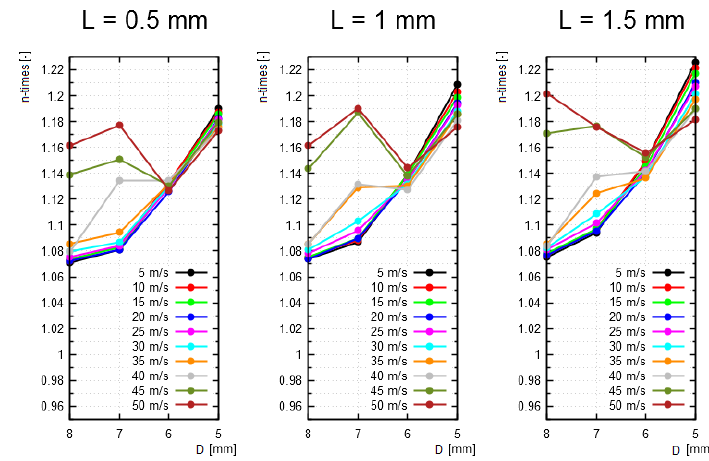
Figure 13. Influence of impacting velocity on a pulse length (L - length of the pulse shaper, D - diameter of the pulse shaper